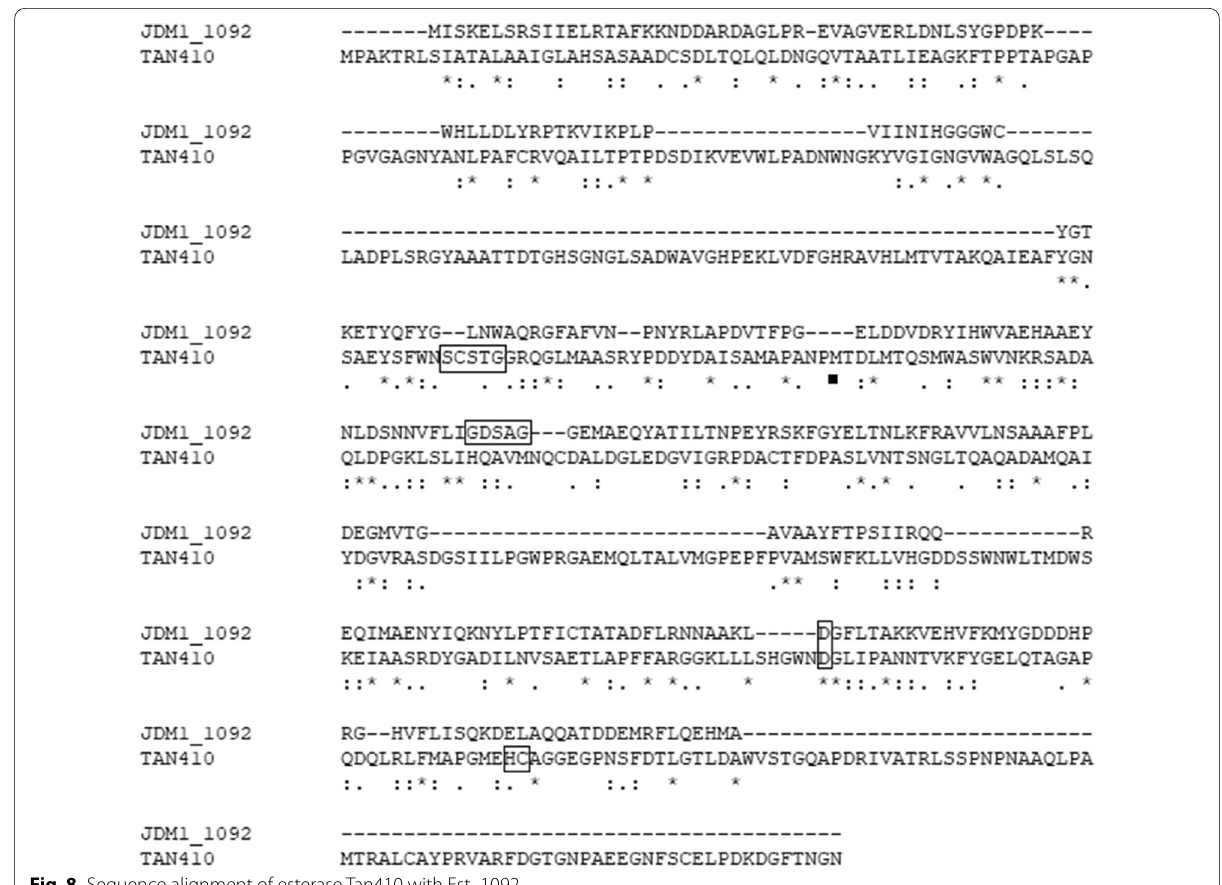
Fig. 8 Sequence alignment of esterase Tan410 with